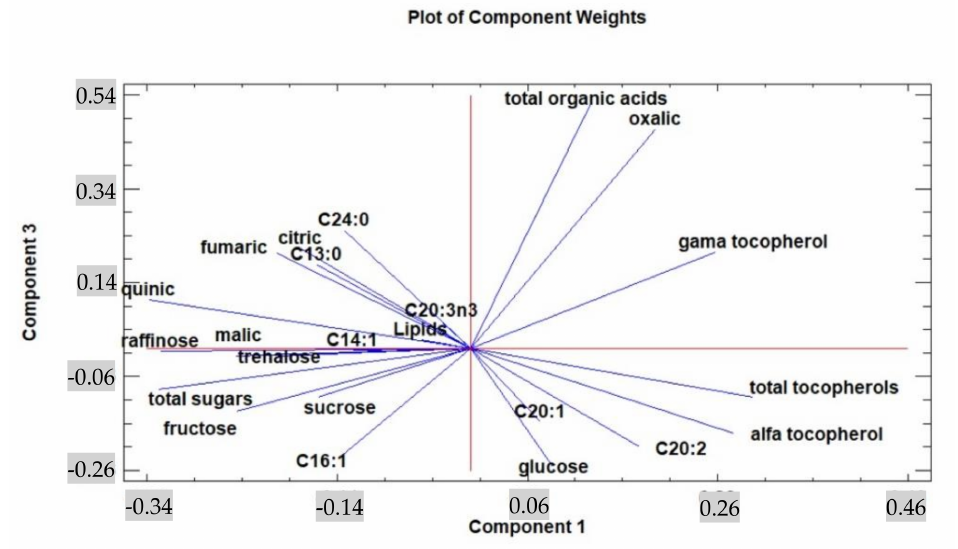
Figure 5. The loading plot of principal components 1 and 3 for the tested variables at different maturation stages of cardoon